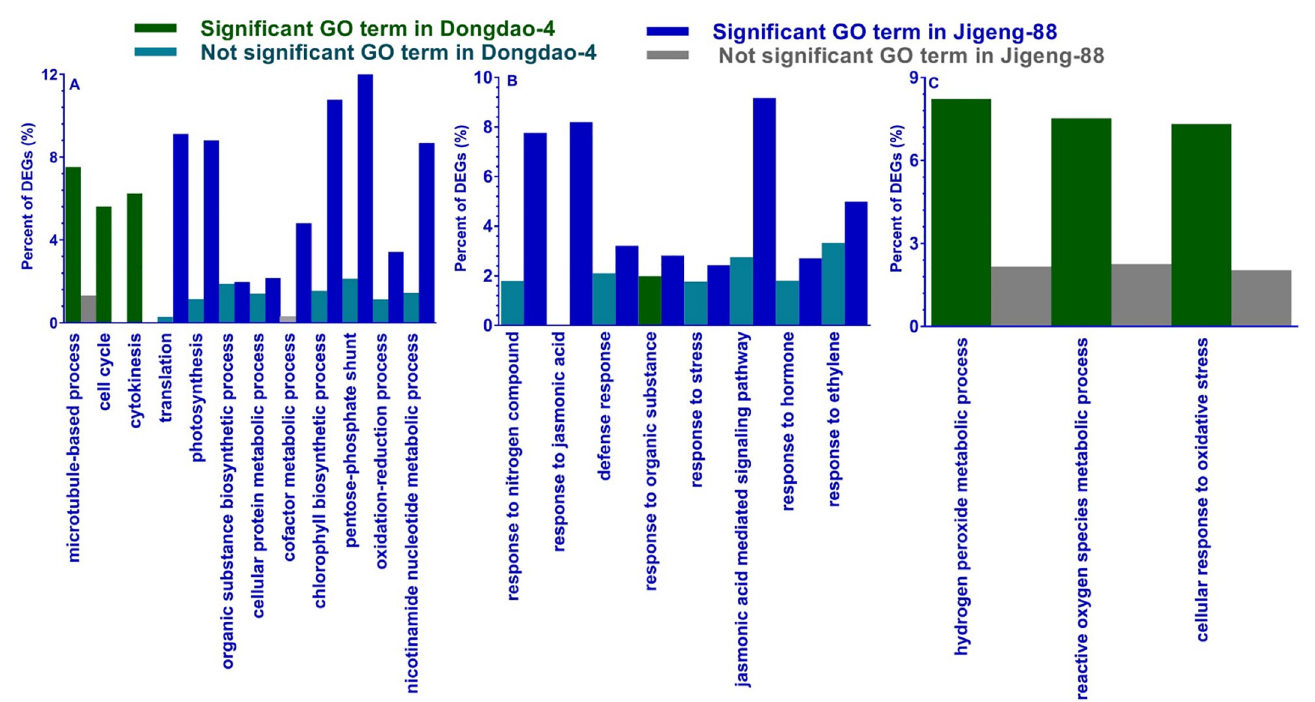
Fig 4. Significantly enriched GO terms at the biological process ontology level for differentially regulated genes in Dongdao-4 and Jigeng-88. (A) GO terms specifically enriched by downregulated DEGs in shoots, (B) GO terms specifically enriched by upregulated DEGs in roots, (C) GO terms specifically downregulated DEGs in roots. GO terms were defined as significantly enriched if the false discovery rate (FDR) was � 0.05. Green and red bars represent significantly enriched GO terms in Dongdao-4 and Jigeng-88, respectively. Blue and gray bars represent GO terms that are not significantly enriched in Dongdao-4 and Jigeng-88, respectively.